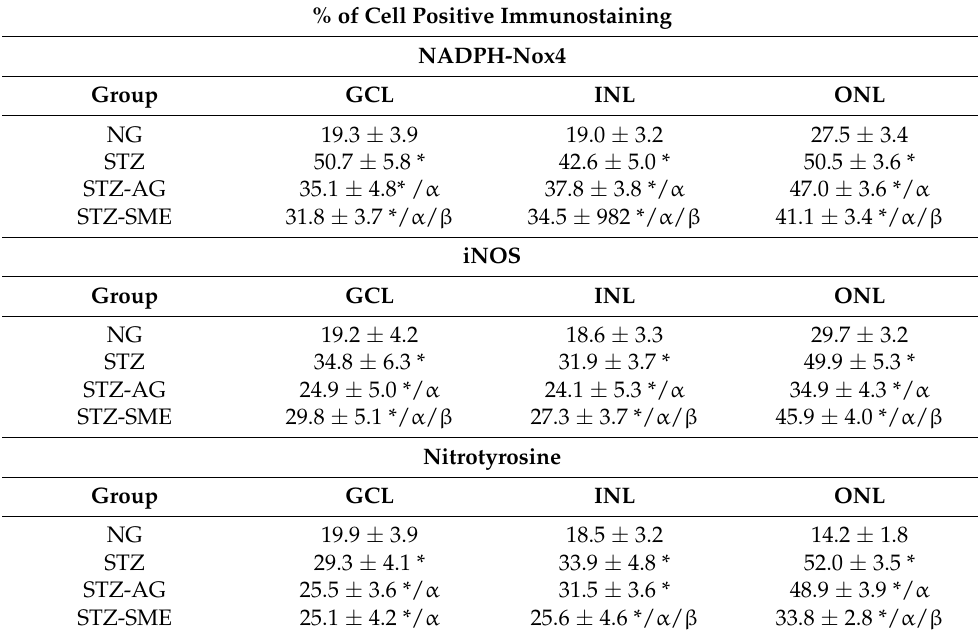
Table A2. Antioxidant effect of SME on the retina of STZ rats.